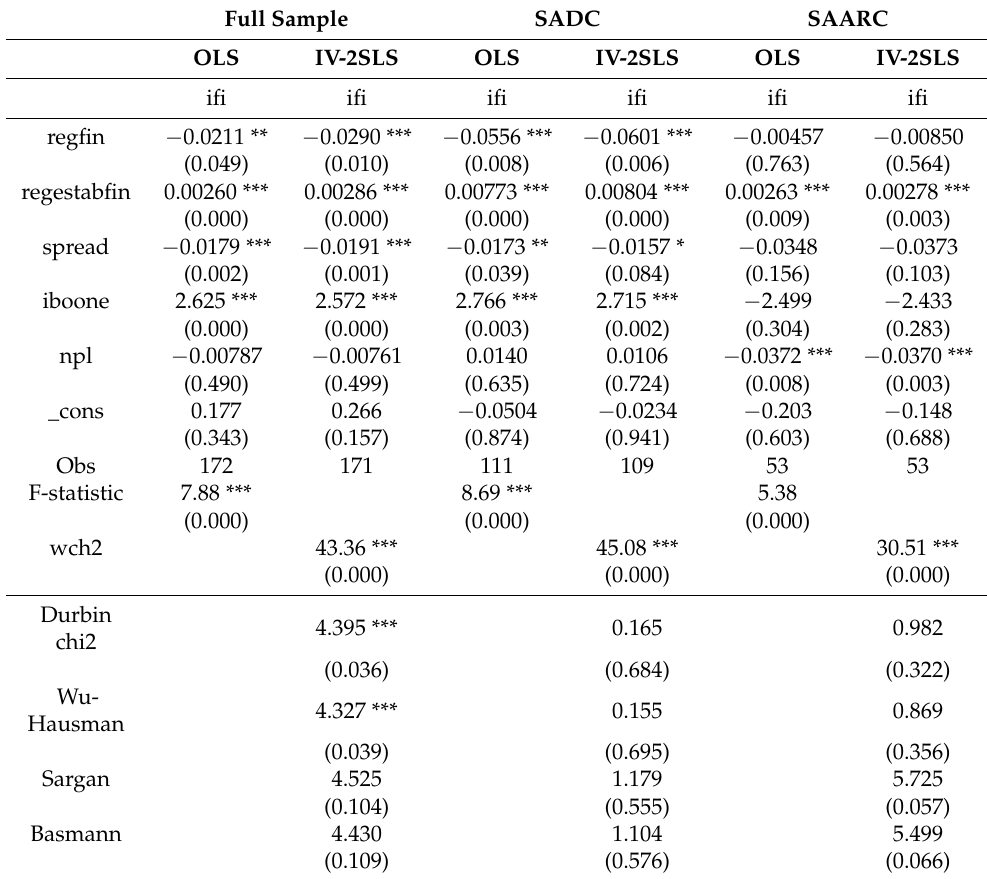
Table 10. IV-2SLS estimation results and endogeneity